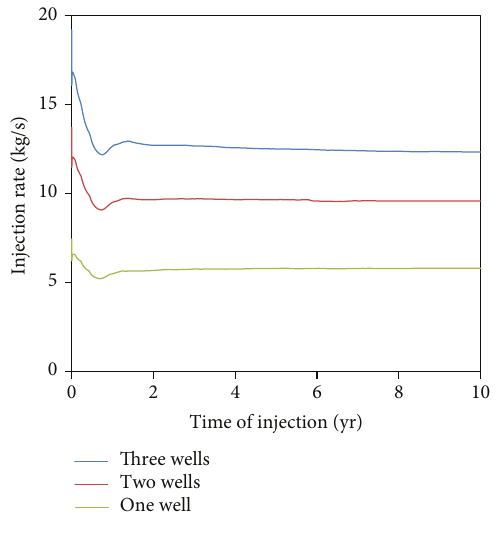
Figure 22: Injection rate of every model.